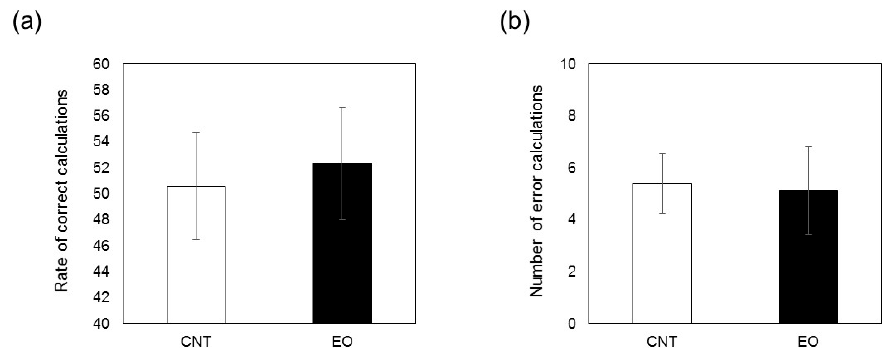
Figure 9. ( a ) Rate of correct calculations during arithmetic work. The bars represent the rate of correct calculations in the control (white) and Japanese cedar wood essential oil (experimental; black) conditions. CNT indicates the control condition, while EO indicates the experimental condition. Differences between both conditions were not significant. Data are shown as mean ± SEM; ( b ) Total number of error calculations during arithmetic work. The bars represent the total number of correct calculations in the control (white) and Japanese cedar wood essential oil (black) conditions. Differences between conditions were not significant. Data are shown as mean ± SEM.